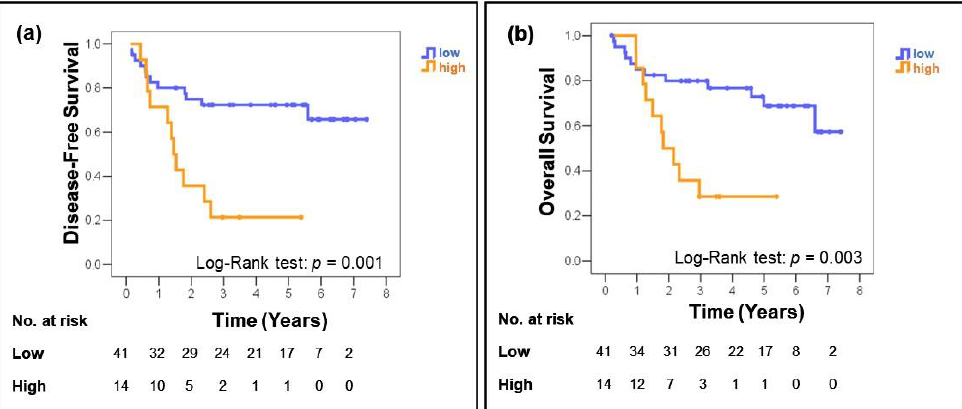
DFS = disease-free survival. OS = overall survival. # HR (hazard ratio) = hazard ratio to relapse, with censored = 32 patients and relapse = 23 patients. ## HR (hazard ratio) = hazard ratio to death, with censored = 33 patients and death = 22 patients. CI = confidence interval. * Some cases lacked information on tumor grade, acute toxicity, and late toxicity; therefore, only cases with such information are presented. α SOD2 expression was translated into a score based on the ratio of stained cells and on staining intensity and then classified as low (<1.9) or high expression ( ≥ 1.9).